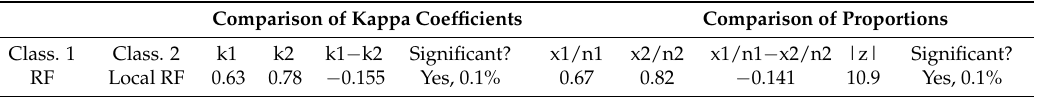
Figure 9. Results of the land cover classification accuracy produced by the local classifier optimization. The red squares in image ( a ) are the areas classified using a local model. Each local model is trained using the sample found inside the sample-search circle. Circles of different circumference are shown around each area being classified. Land cover mapping accuracy as a function of the size of the searching-samples circle is presented in graph ( b ). Land cover mapping accuracy for two boundary cases are presented in graph ( c ). Table 5. Summary of evaluation of the statistical difference between the accuracies of classifications produced by traditional random forest (RF) and local optimization approach.